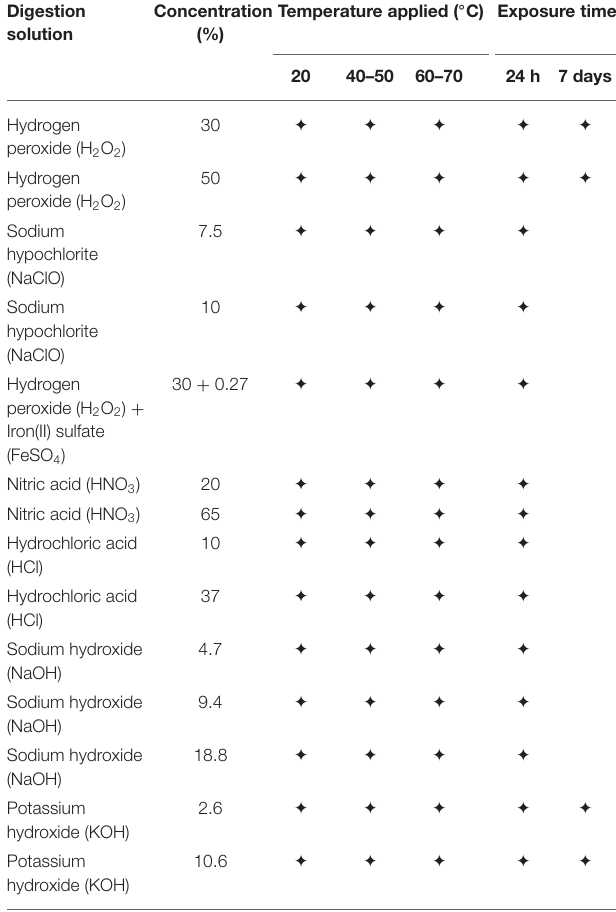
TABLE 1 | List of the applied digestion solutions with corresponding concentrations, temperatures, and exposure